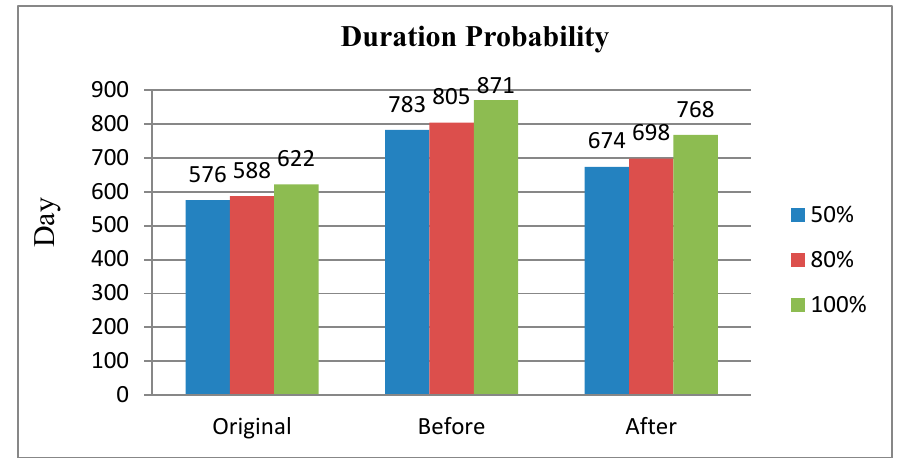
Figure 11. Comparison of project duration schedules.